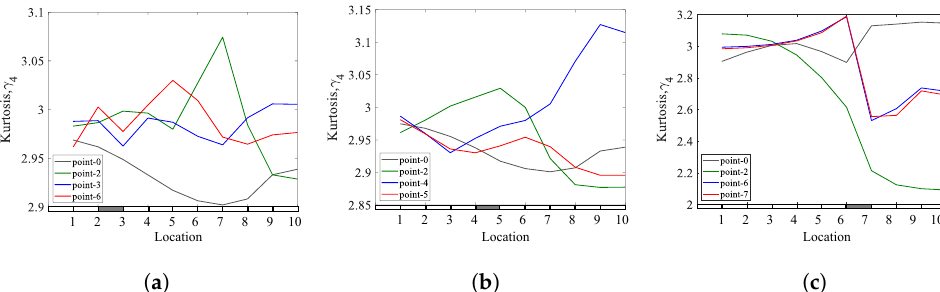
Figure 30. The effect of changing excitation locations on the kurtosis coefficients of a simply supported beam with a single breathing crack: ( a ) q 1 = 0.25; ( b ) q 2 = 0.45; ( c ) q 3 = 0.65.